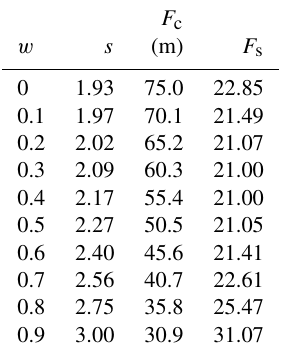
Table 1. Table of parameters in the cliff-calving relation (Eq. 23), giving the exponent s , critical freeboard F c and scaling factor F s for a range of relative water depth values w